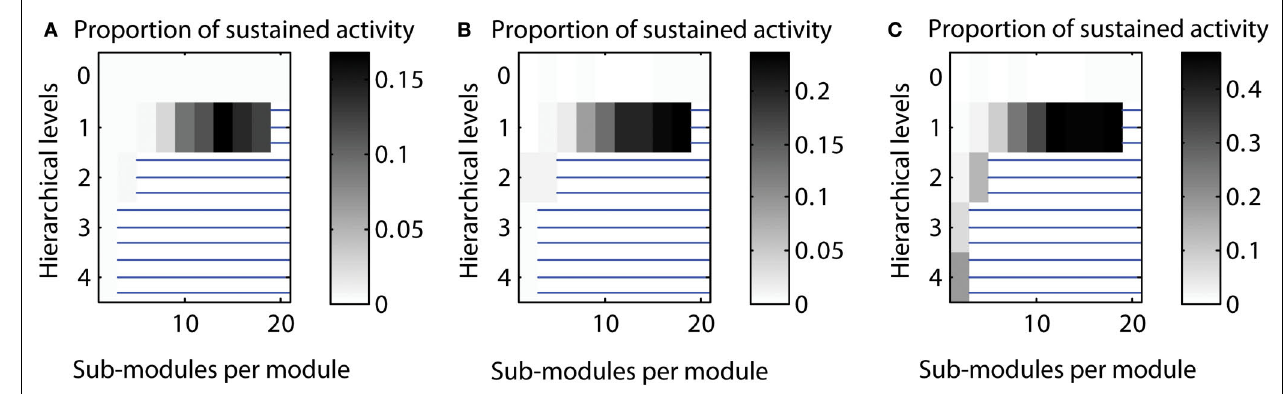
FIGURE 7 | Varying the number of edges per hierarchical level. (A) Decreasing number of edges for higher hierarchical levels [ E independent from hierarchical level ( E